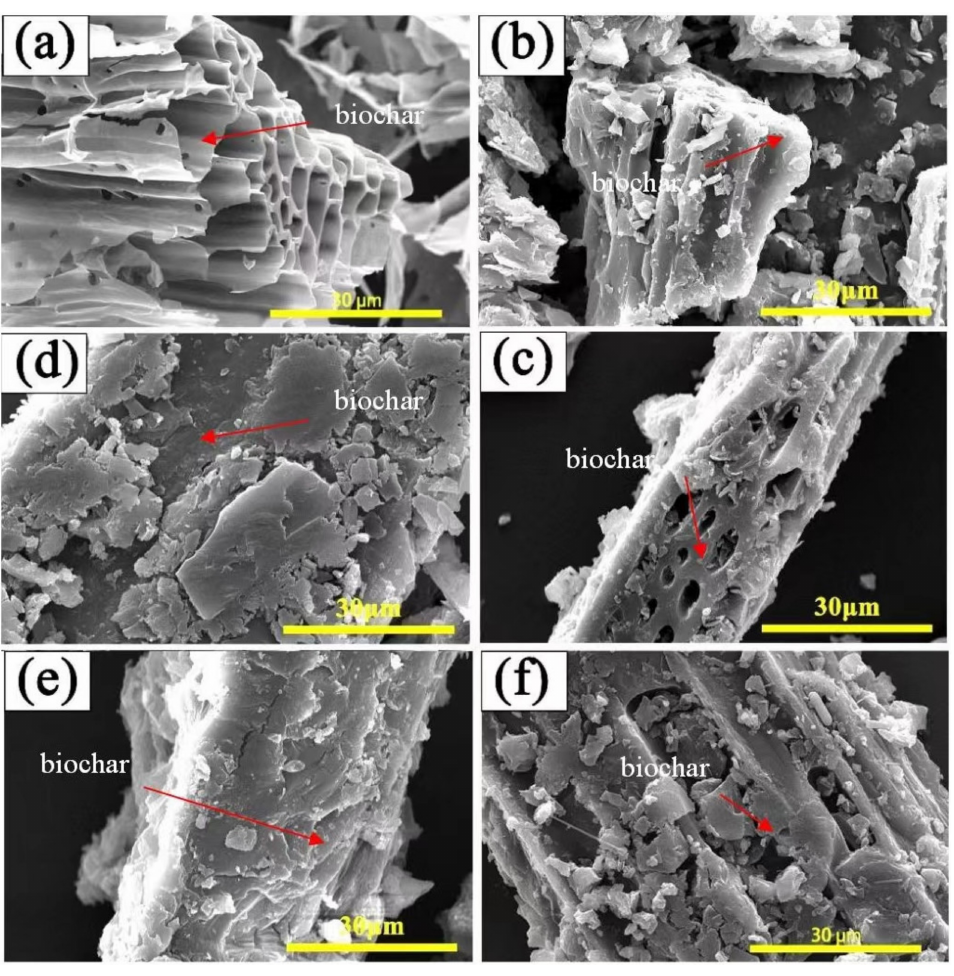
Figure 5. SEM images of ( a ) CS6, ( b ) PGO-CTAB/CS6(5), ( c ) PGO-CTAB/CS6(6), ( d ) PGO-